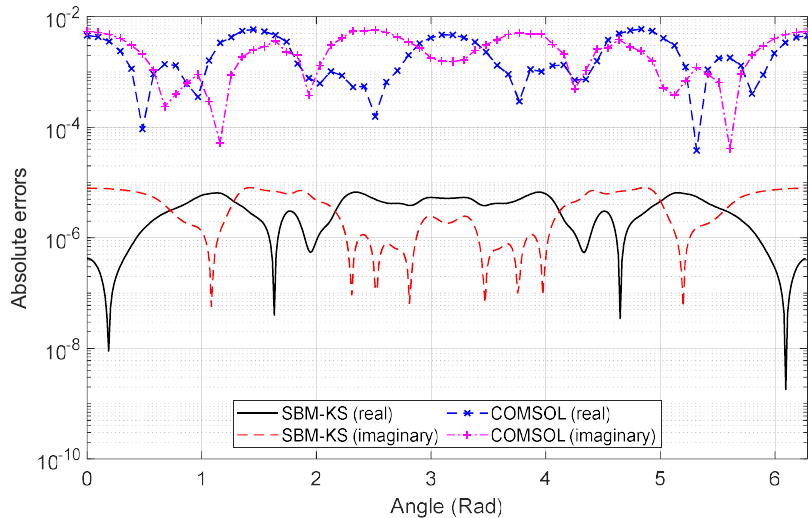
Figure 3. Comparison of the numerical and analytical solutions for hydrodynamic pressures along the common interface under a frequency of 1000 Hz.